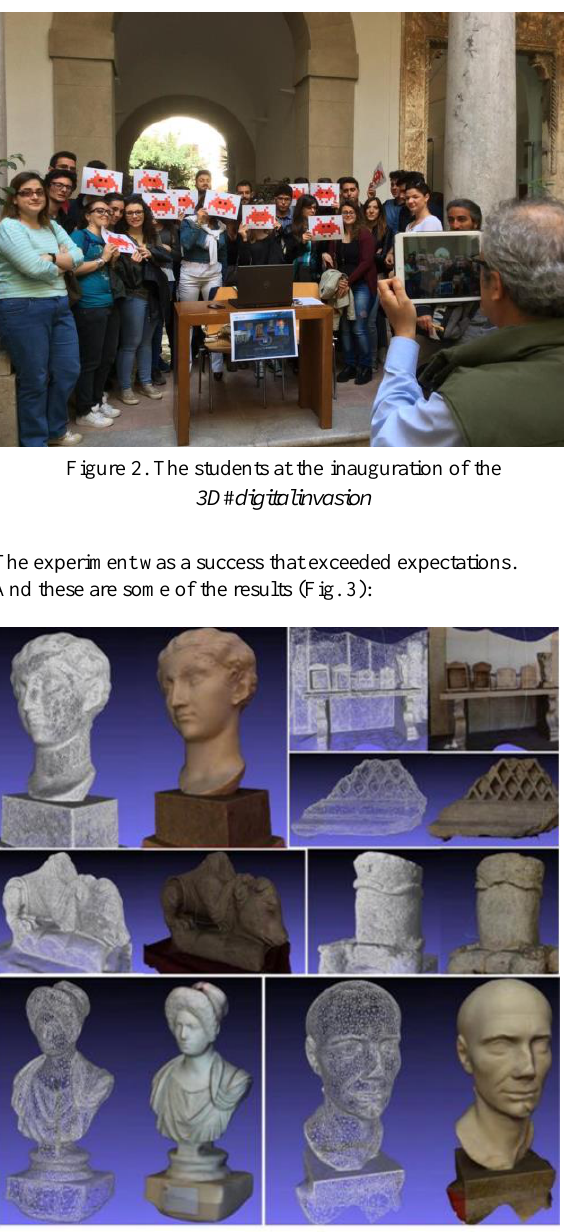
Precisely from these results comes the idea of the smart SfM